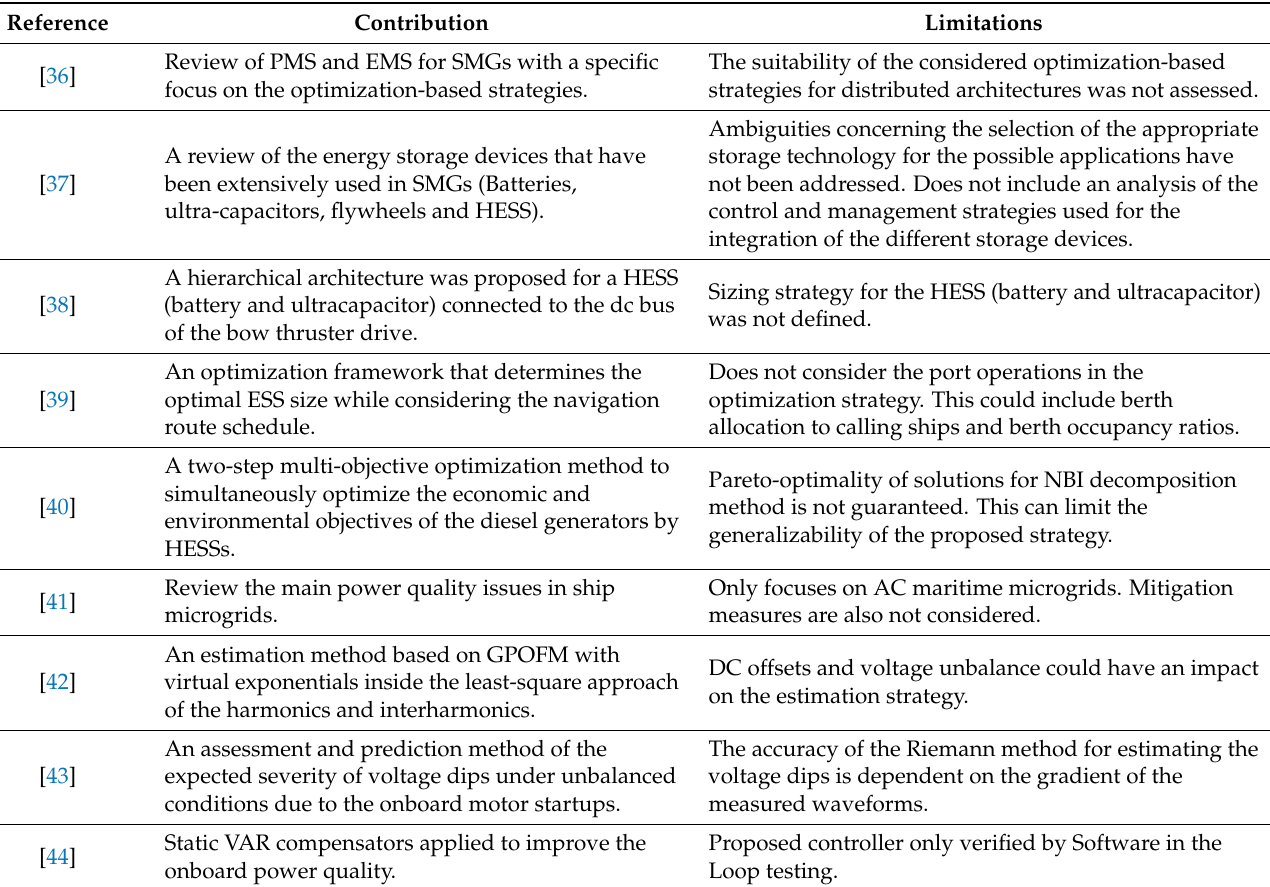
Table 2. Main contributions in recent literature focusing on